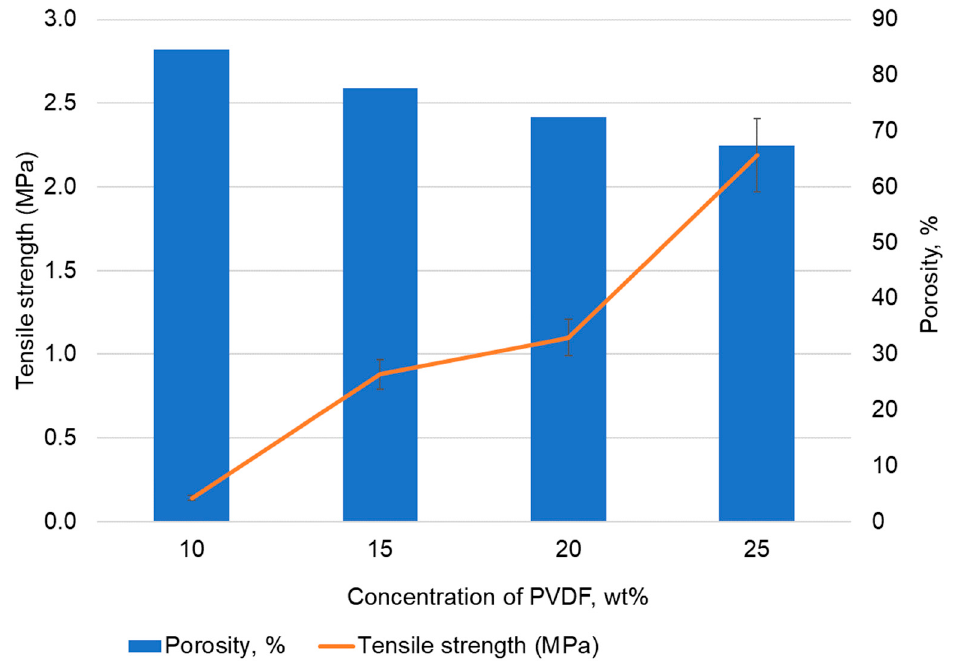
Figure 3. Comparison of the tensile strength and porosity of the prepared membranes.